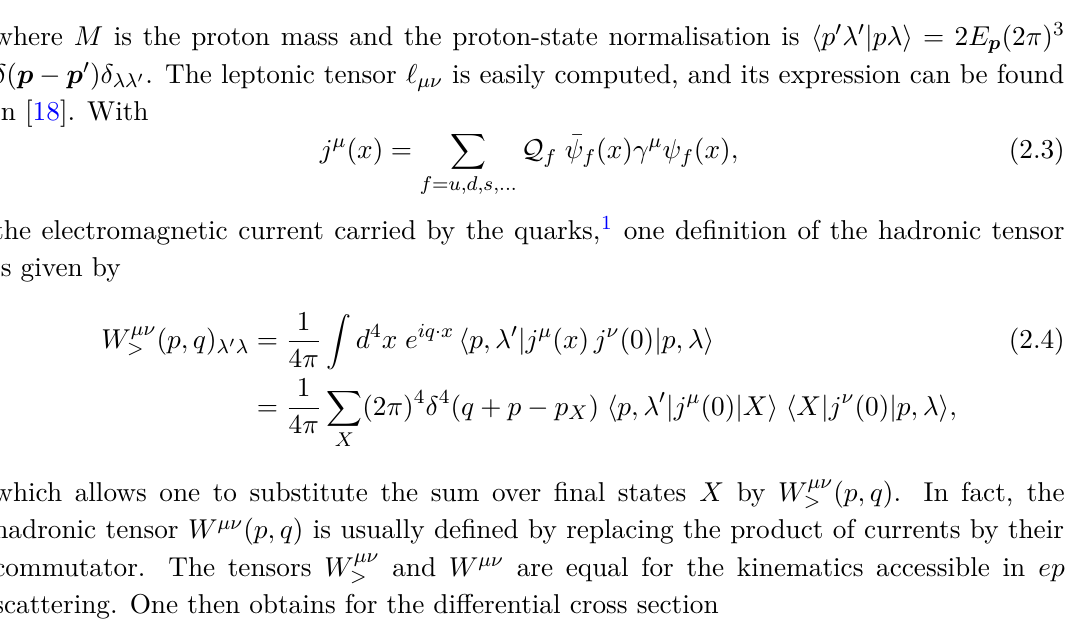
Figure 1 . Left: Scattering of a lepton on quark-gluon plasma at global thermal equilibrium moving with a four-velocity u in the one-photon exchange approximation. The picture shows the interaction occurring with a cubic fluid cell, producing an unobserved QCD final-state X . Right: interpretation of the process in the deep-inelastic scattering limit as an elastic parton-lepton